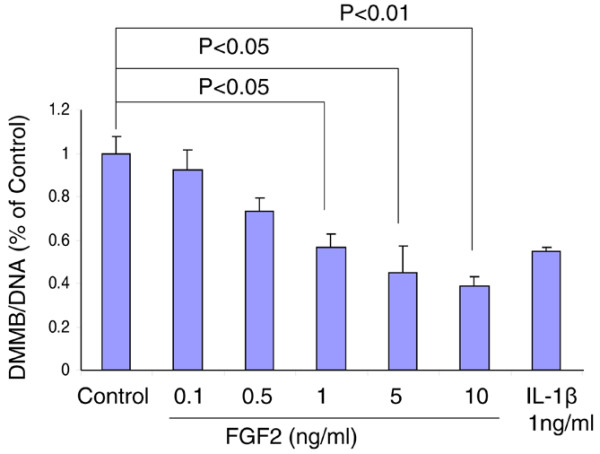
Fibroblast growth factor 2 inhibits proteoglycan accumulation in the cell-associated matrix. Nucleus pulposus cells isolated from bovine intervertebral disc were cultured for 21 days in 1.2% alginate beads in serum-free medium with mini-insulin–transferrin–selenium (control) or the control medium plus 0.1 to 10 ng/ml fibroblast growth factor 2 (FGF2). Control medium plus 1 ng/ml IL-1β was used as a positive control. At the end of the culture period, the beads were dissolved in sodium citrate and cell pellets were separated by centrifugation. The amount of proteoglycan in the cell-associated matrix around the cells was measured by dimethylethylene blue assay and normalized to cell numbers using DNA measurement (DMMB/DNA). Samples were measured in triplicate and expressed as a percentage of the day 21 control cultures. Error bars represent three different donors in three separate experiments.